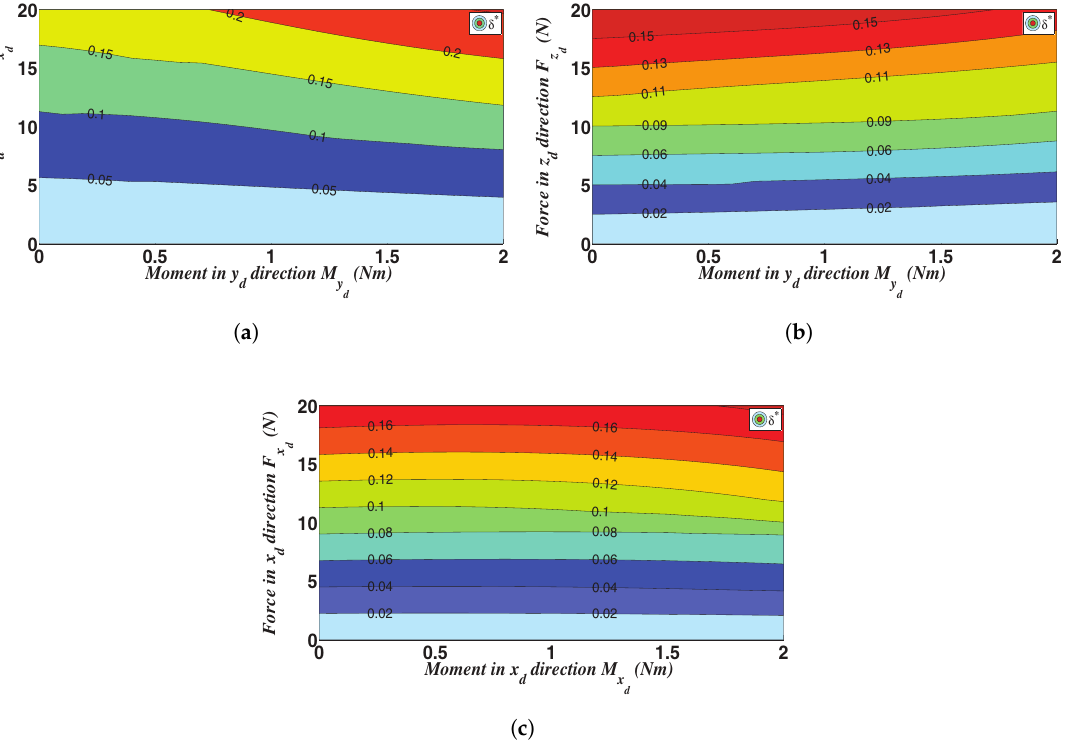
Figure 8. Contour plots of δ ∗ for three extreme loading cases: ( a ) moment M y M y and force F z d